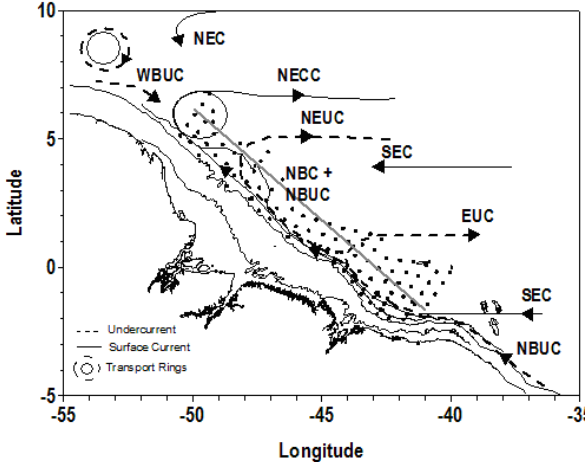
Fig. 1. Map of the north Brazilian zone. Dots are the locations of the CTD stations. Surface and subsurface currents area repre- sented by solid and dashed lines, respectively. NBC – North Brazil Current, NECC – North Equatorial Countercurrent, SEC – South Equatorial Current, EUC – Equatorial Undercurrent, NEUC – North Equatorial Undercurrent, NEC – North Equatorial Current. Isobaths 20m, 100m and 2000m depth are also represented. The alongshore solid straight gray line indicated the position vertical distributions in Fig.